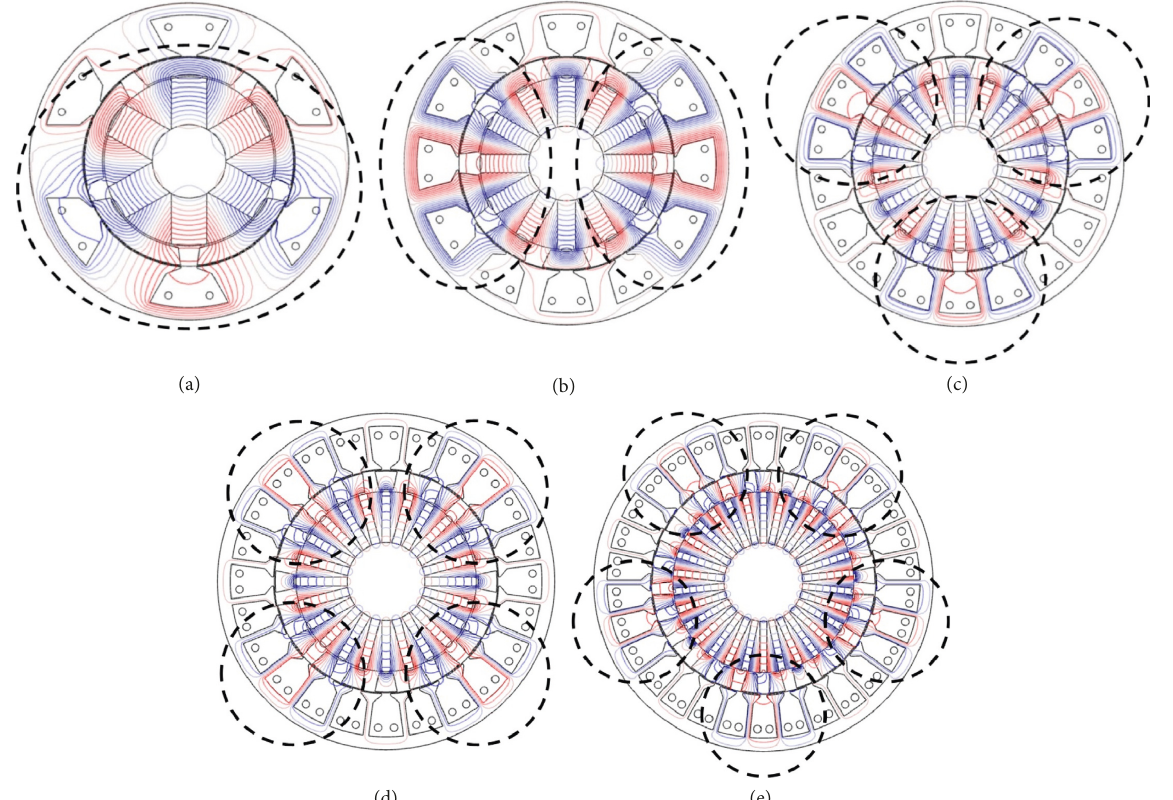
Figure 2: Open-circuit magnetic field distributions at 0 degrees of (a) 6/5, (b) 12/10, (c) 18/15, (d) 24/20, and (e) 30/25-pole PS-DSPG structures.